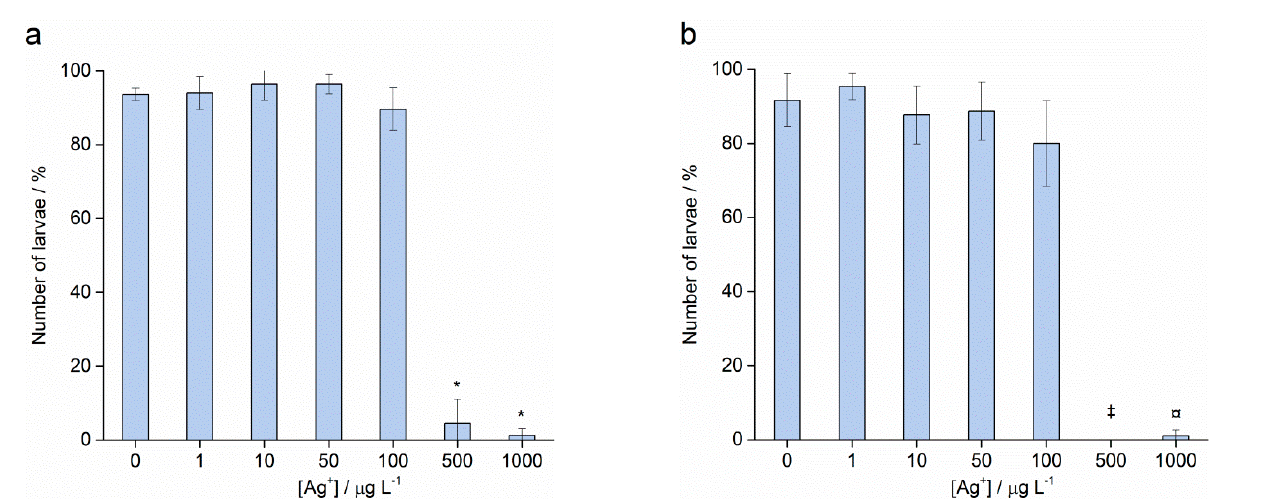
Figure 6. Fertilisation success for ( a ) A. lixula and ( b ) P. lividus after sperm pre-treatment with Ag + ions (grey bars) and non-treated sperm (white bars) ( ± SD). Significance levels: ¤ p < 0.01, * p < 0.001, (‡ for the 500 µg L − 1 treatment in P. lividus , no fertilised eggs were observed.